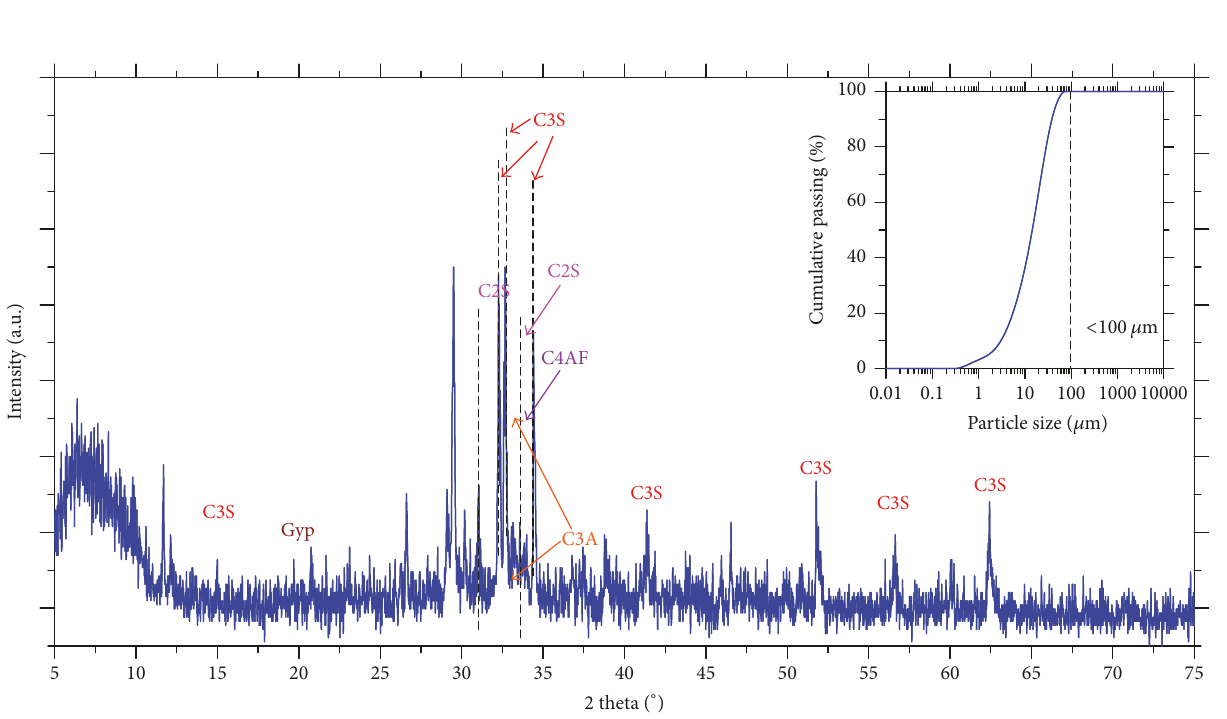
Figure 1: Particle size and minerals phases of raw materials.